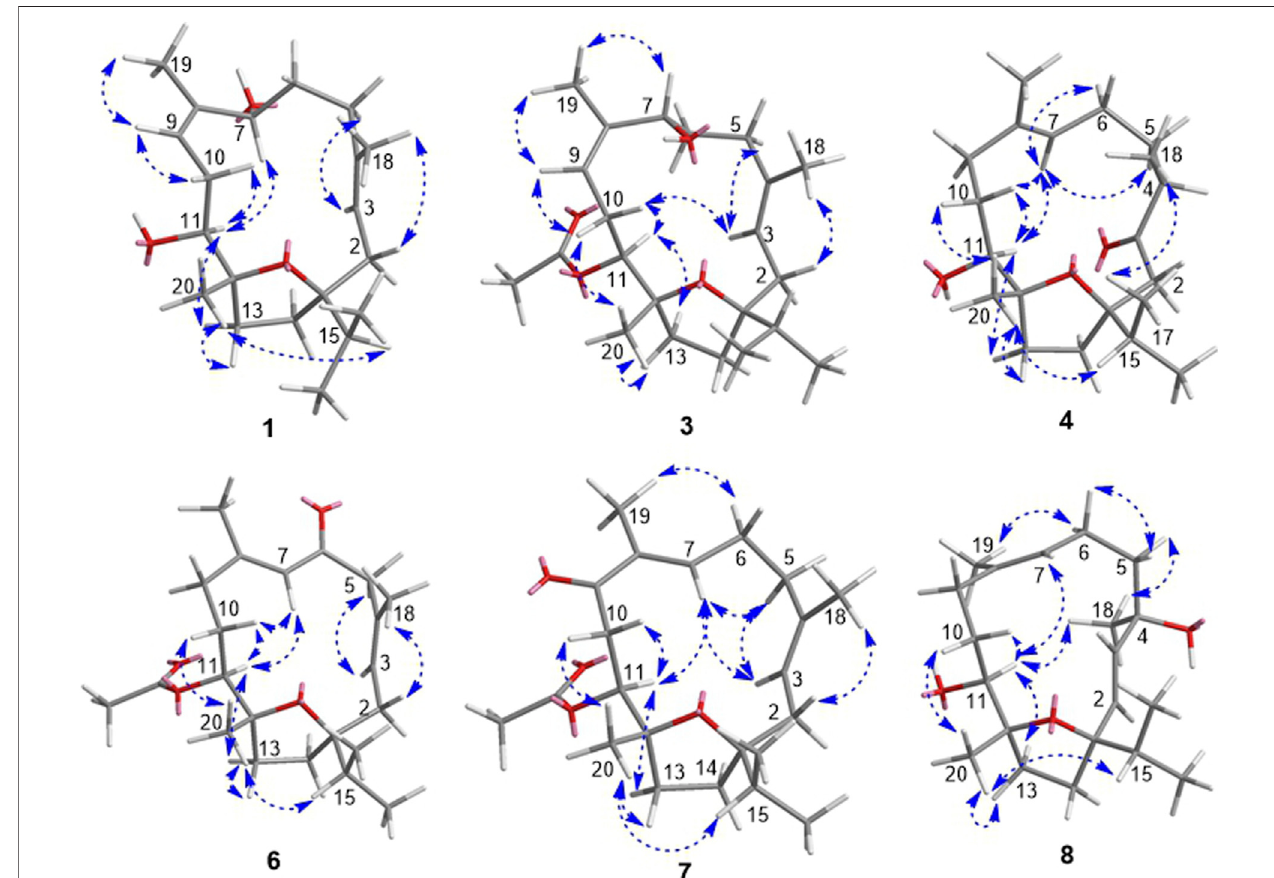
FIGURE 3 | Key NOESY correlations of compounds 1 , 3 – 4 , 6 – 8